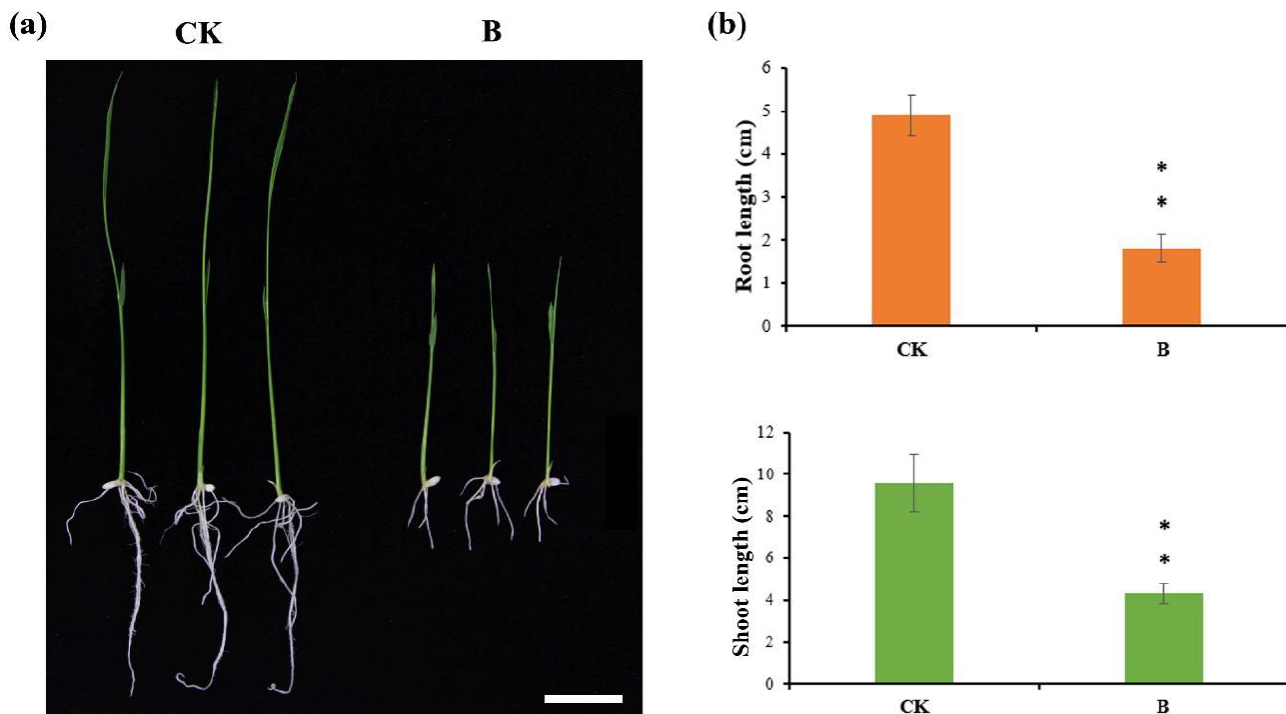
Figure 2. Phenotype of seedlings treated with bleomycin. ( a ) Morphological comparison of seedlings treated with 0 (left) or 10 μg/mL (right) bleomycin for 12 d. Scale bar = 2 cm; ( b ) Length of seedling roots (above) and shoots (below) treated with bleomycin at concentrations of 0 (CK) or 10 (B) μg/mL for 12 d. Student’s t-test: ** p < 0.01